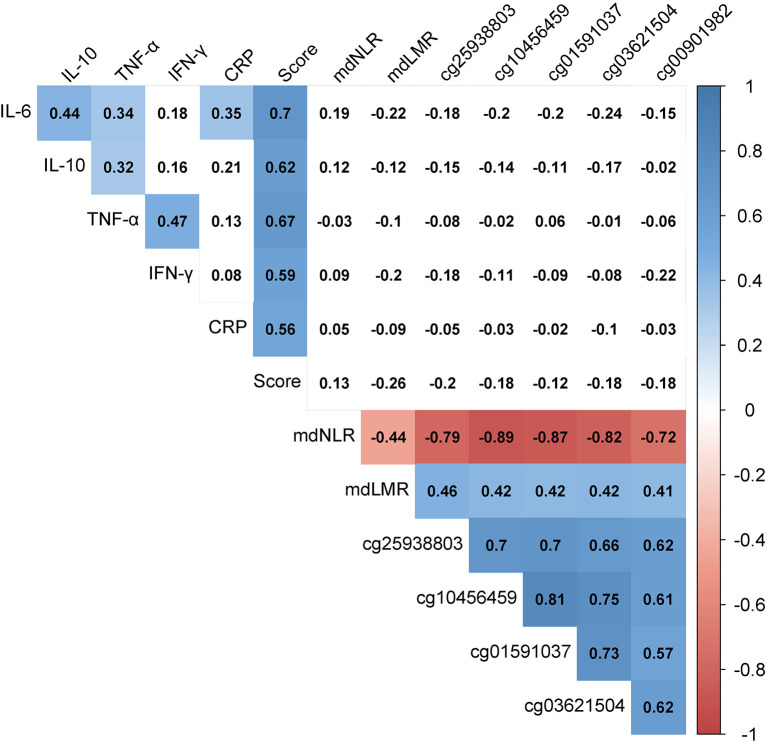
Heat map of the partial Spearman correlations among protein-based and methylation-derived biomarkers of inflammation. Numeric values indicate Spearman's rho values while controlling for age and smoking status. The presence of color indicates p < 0.003 (α = 0.05/16, calculated as 4 × 4 independent inflammatory marker comparisons). The shades of color represent the strength and direction of the correlation. “Score” represents the average of the IL-6, IL-10, TNA-α, IFN-γ, and CRP z-scores. CRP, C-reactive protein; IFN-γ, interferon-gamma; IL-6, interleukin-6; IL-10, interleukin-10; mdLMR, methylation-derived lymphocyte-to-monocyte ratio; mdNLR, methylation-derived neutrophil-to-lymphocyte ratio; TNF-α, tumor necrosis factor-alpha.